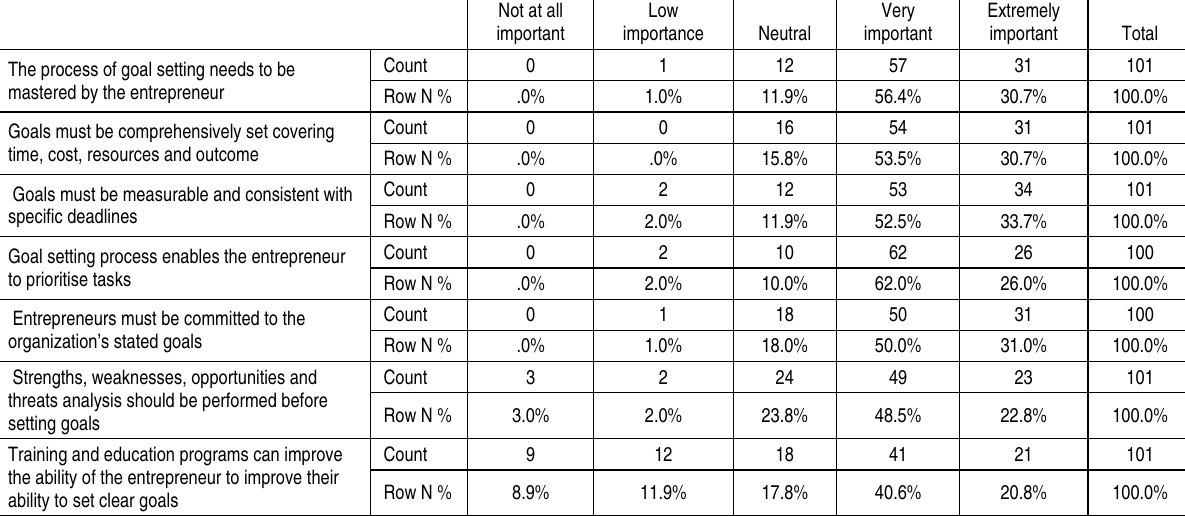
Table 5. The skill of goal setting and commitment – level of